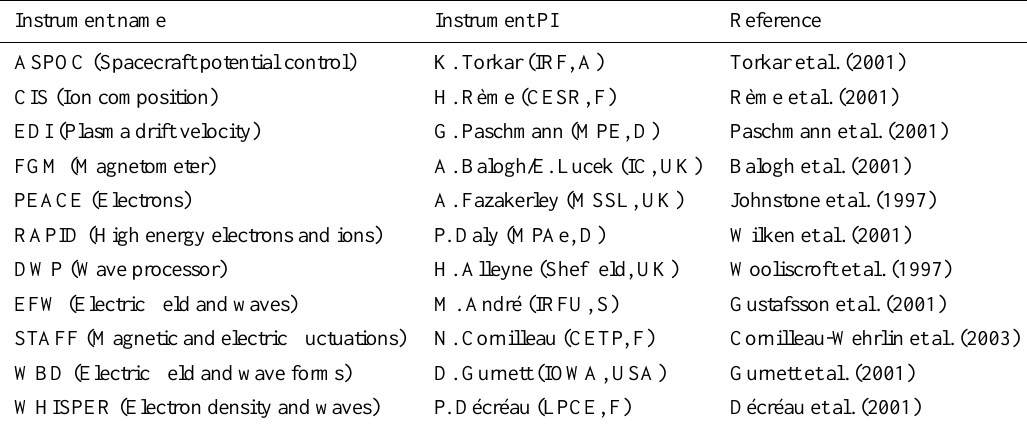
Table 1. Cluster instruments, instrument PIs, and relevant